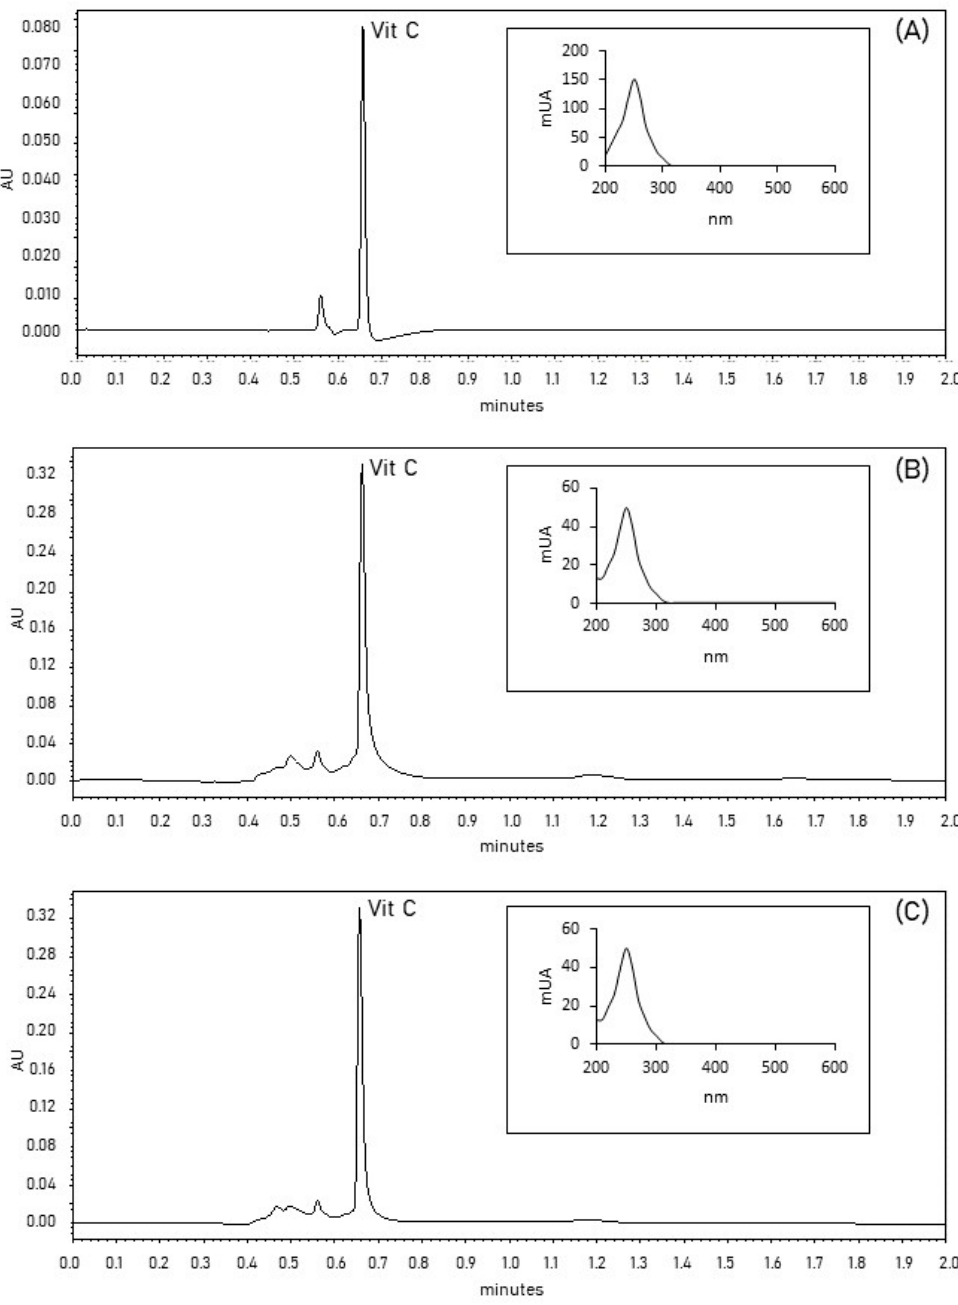
Figure A2. Chromatograms of Vitamin C (vit C) at 244 nm. ( A ) Standard. ( B ) Extracted from unripe Habanero pepper grown in red soil and harvested at 320 PTD. ( C ) Extracted from ripe habanero pepper grown in red soil and harvested at 320 PTD. Extraction method: 50 mg of Habanero pepper powder with 4 mL of water:acetonitrile (80:20) was sonicated at 42 KHz for 30 min then, filtered through a 0.2 µm PTFE filters.